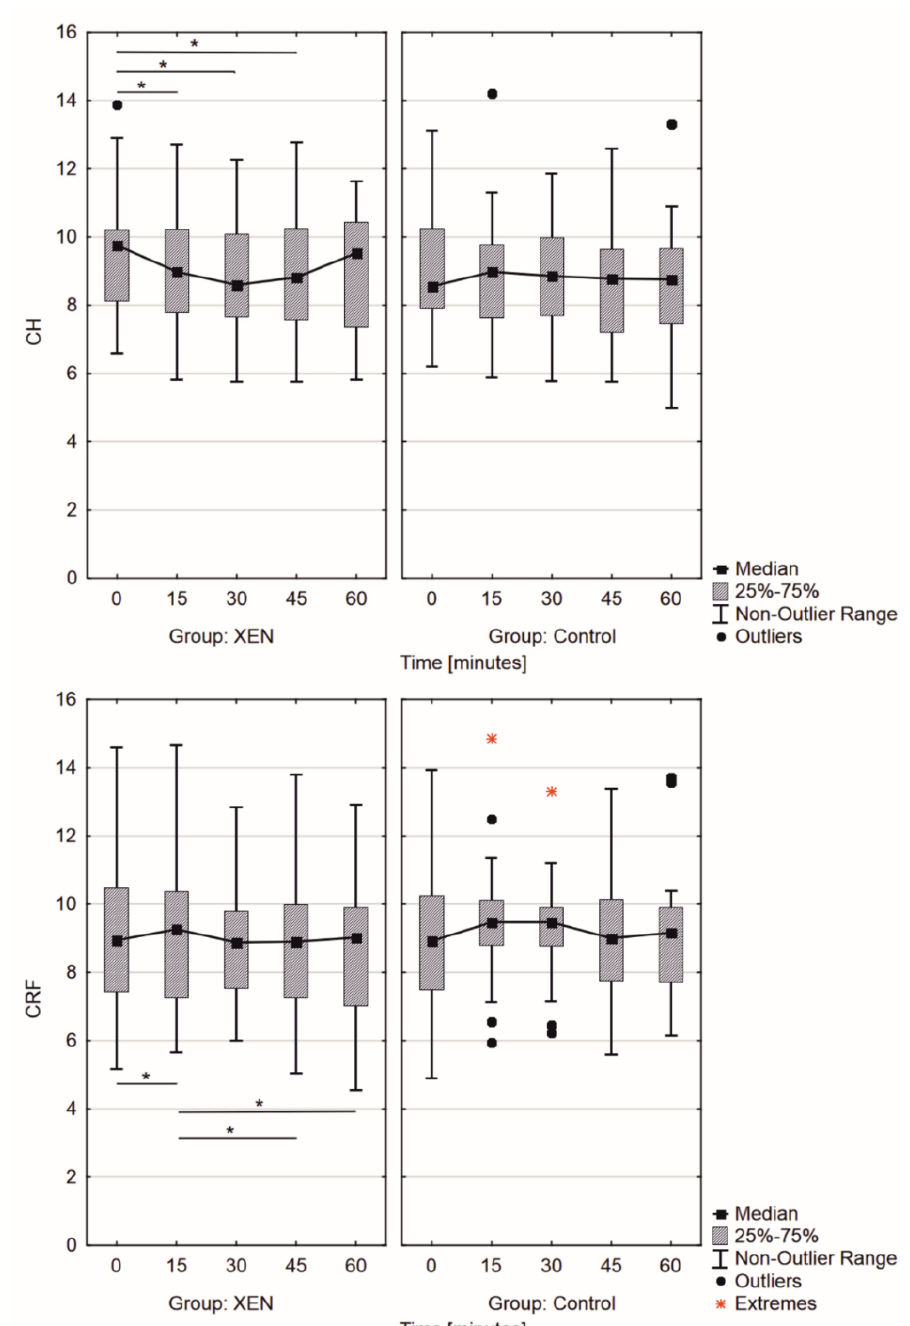
Figure 4. Changes in ( top ) corneal hysteresis (CH) and ( bottom ) corneal resistant factor (CRF) measured by Ocular Response Analyzer in the examined groups during the water drinking test. (* p < 0.05, Friedmann test).